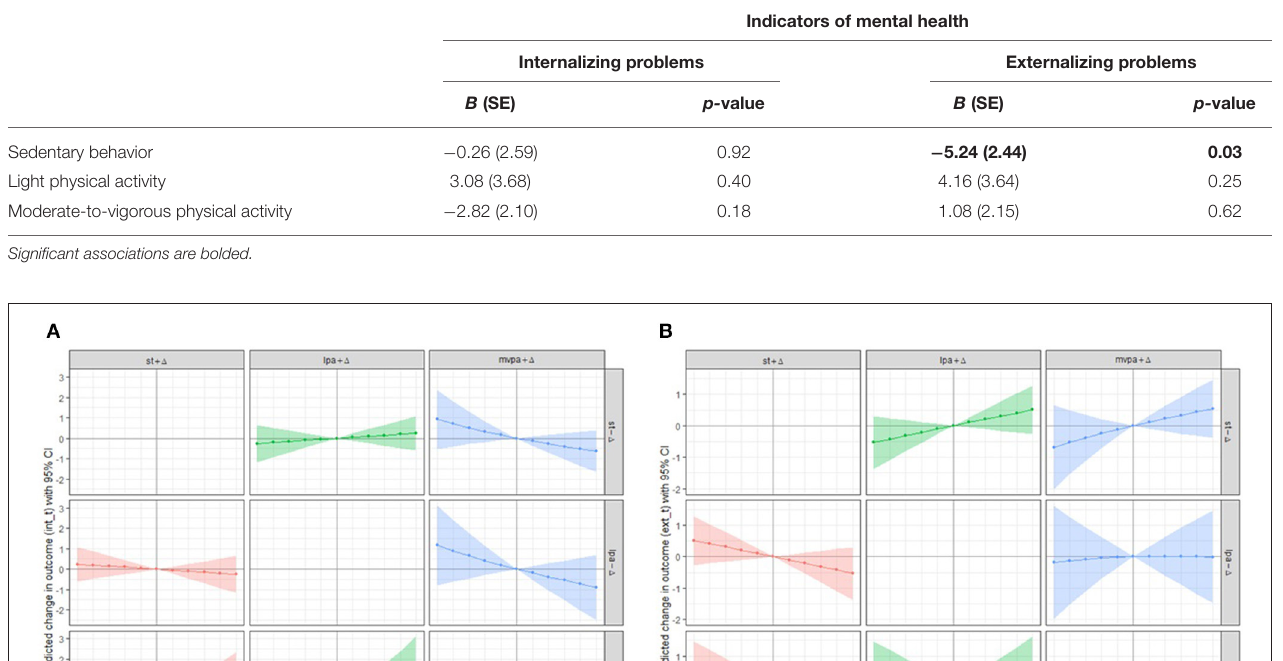
associations between sedentary time, LPA and MVPA with indicators of mental health. Findings demonstrated a significant negative relationship for sedentary time (relative to time in LPA and MVPA) and externalizing problems, whereas null associations were observed for each of the other